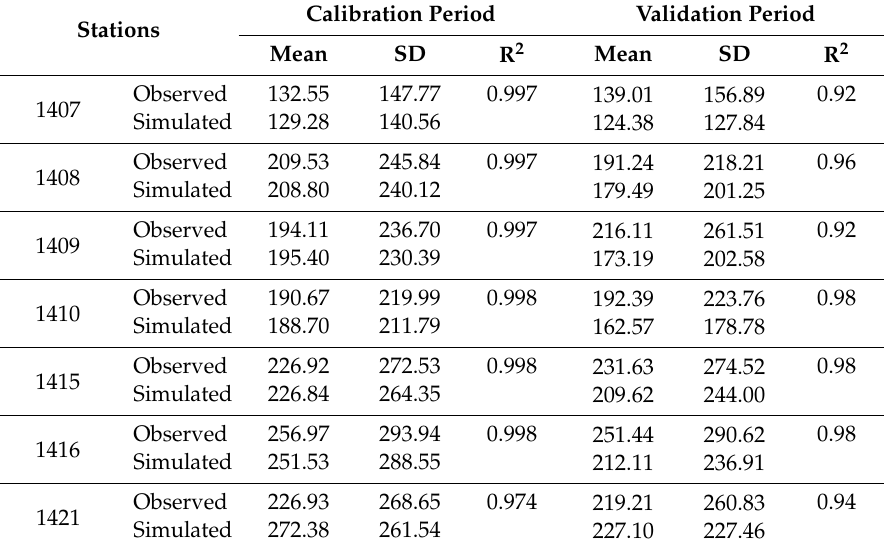
Table 5. Statistical comparison between the observed and simulated monthly precipitation for calibration period (1961–1990) and validation period (1991–2005). Calibration Period Validation Stations